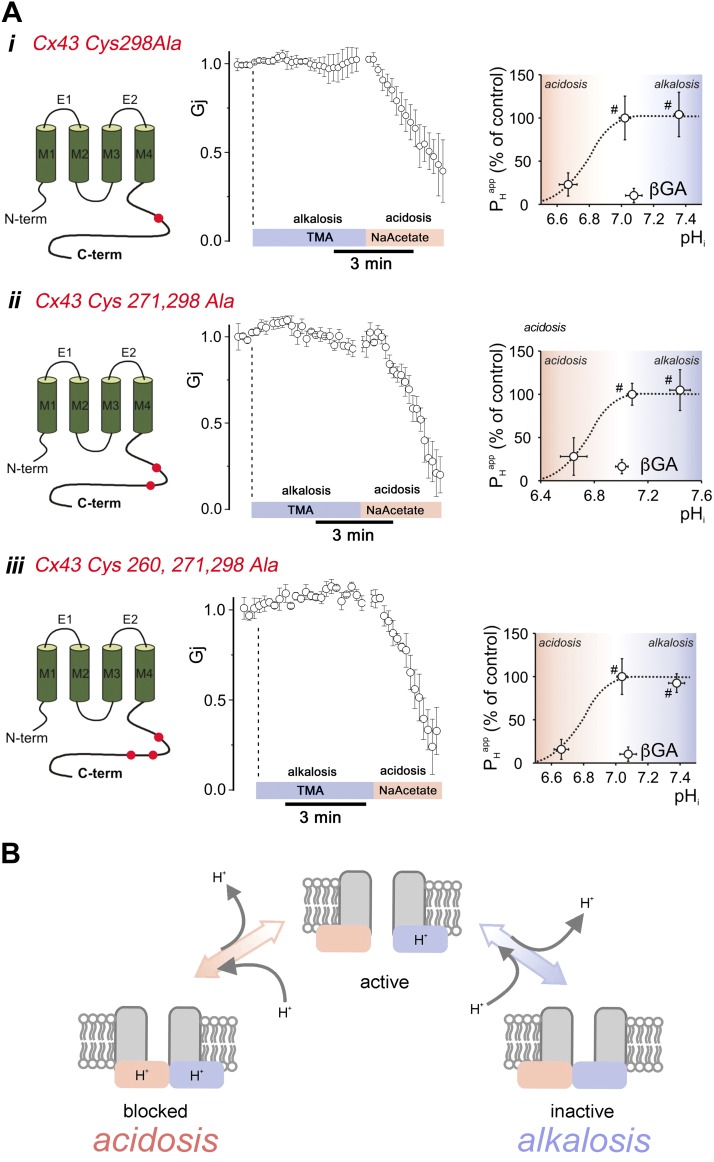
Involvement of cysteine residues in alkali gating. Ai) Cysteine 298–alanine Cx43 mutants demonstrated no inhibitory effect of alkalosis on Gj (40 mM TMA) under double whole-cell voltage clamp in cell triplets (n = 4). Eighty millimolar acetate, which induces acidosis, produced a prompt inhibition of mutant Cx43 channel activity (n = 3). Effect of high and low pHi on PHapp as determined by H+ uncaging showing the ablated response to alkaline pHi but an intact inhibition by acidic pHi. ii) Similar results were obtained by using Cx43 with substituted cysteine residues 270 and 298 (n = 3) and (iii) cysteine residues 260, 271, and 298 (n = 3). #Significantly different from 0 (P < 0.05). B) Schematic representation of H+ activation and H+ inhibition mechanisms on wild-type Cx43 channels. Deprotonated form of Cx43 (lower right) represents the closed state. H+ binding to a low-affinity site activates the Cx43 channel. At higher [H+], protonation at the inhibitory site, with lower apparent H+ affinity, produces H+ block. #Significantly different from 0.